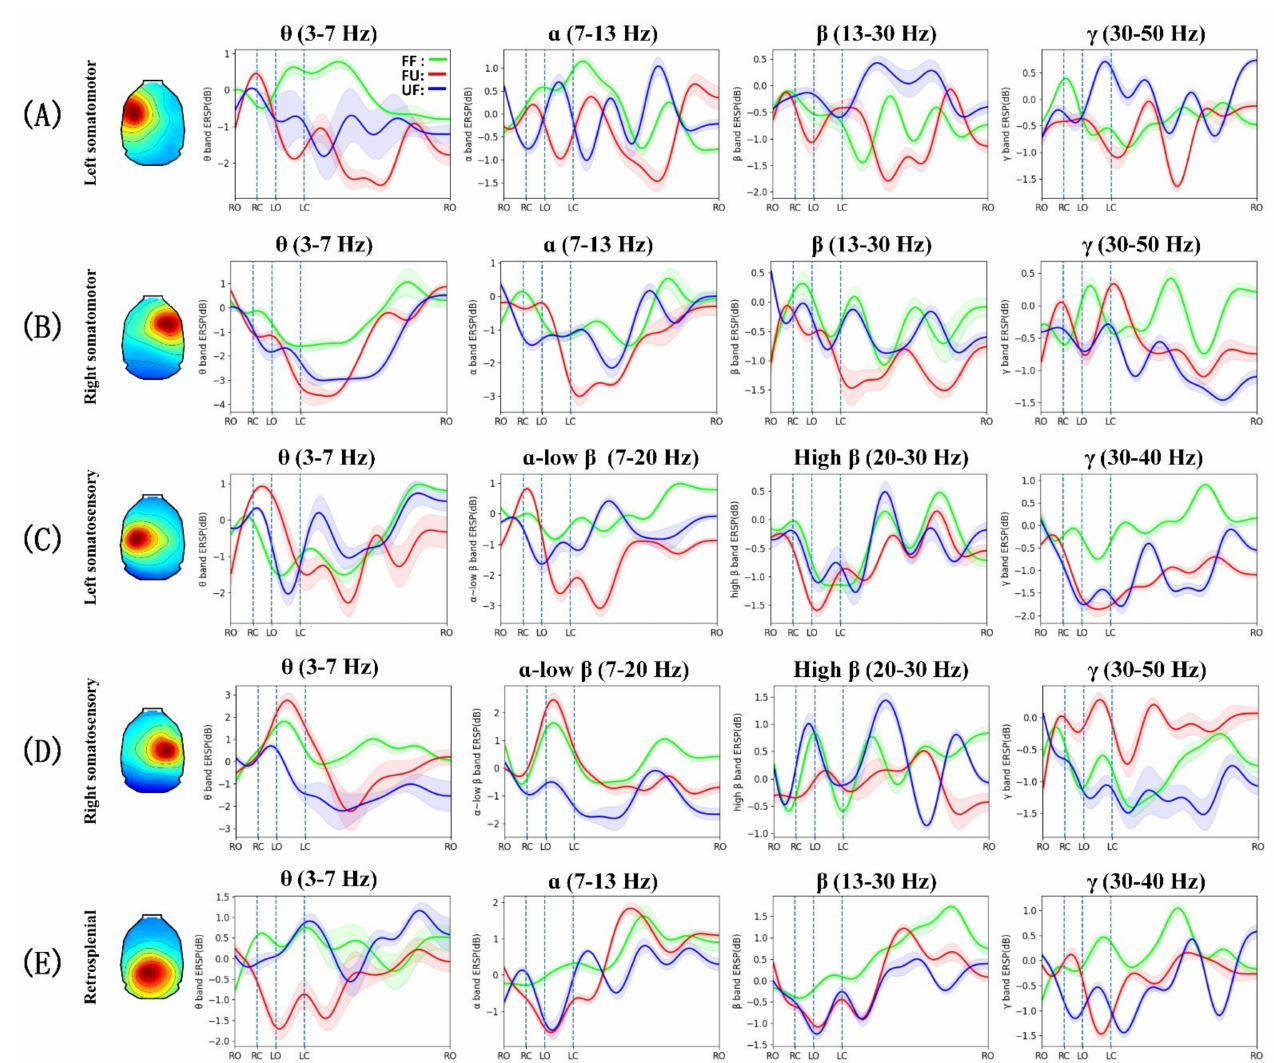
Figure 5. Mean ERSP for the specific frequency bands. ( A , B , E ) Mean ERSP of θ , α , β , and γ bands in the left/right somatomotor clusters and retrosplenial cluster. ( C , D ) Mean ERSP of θ , α to low β , high β , and γ bands in left/right somatosensory clusters. The green, red, and blue lines represent power modulations under FF, FU, and UF conditions, respectively. The 95% confidence interval envelope was plotted around the mean. Dotted vertical lines indicate the time of the gait